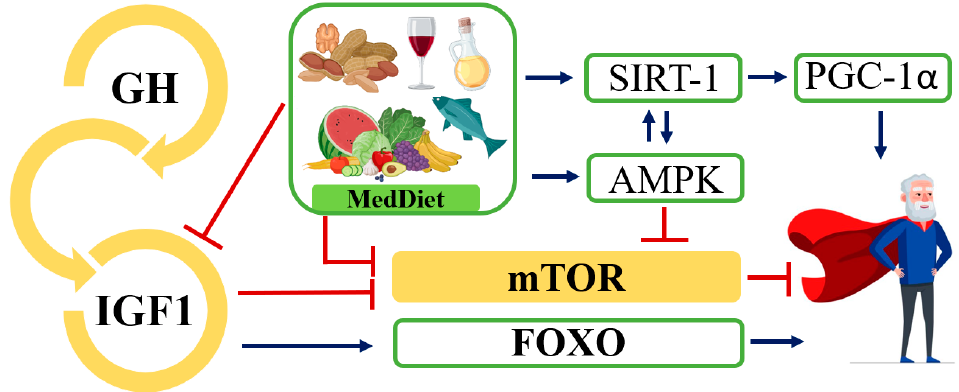
Figure 2. Dysregulated nutrient sensing pathways. Overview of the somatotropic axis, involving GH and the IIS pathway. Molecules that promote aging are shown in yellow, while molecules with anti-aging properties are shown in light green. Red lines indicate inhibited or slowed pathways and blue lines indicate activated pathways that together promote healthy aging. GH, growth hormone; IGF-1, insulin-like growth factor-1; mTOR, protein mammalian target of rapamycin; AMPK, adenosine monophosphate-activated protein kinase; FOXO, Forkhead Box; PGC-1 α , peroxisome proliferator-activated receptor gamma 1-alpha; SIRT-1, sirtuine-1.